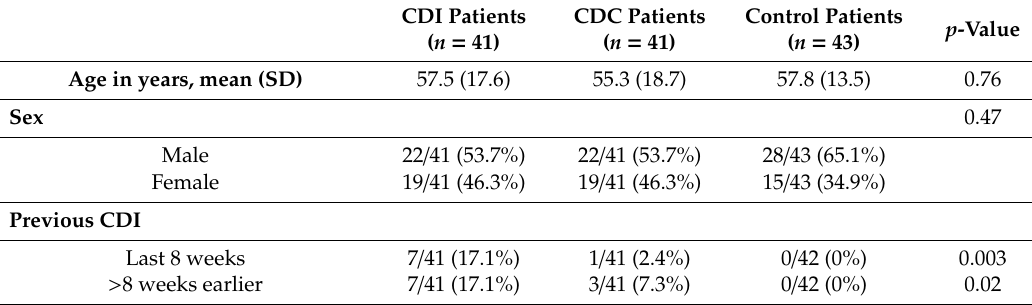
Table 1. Subject